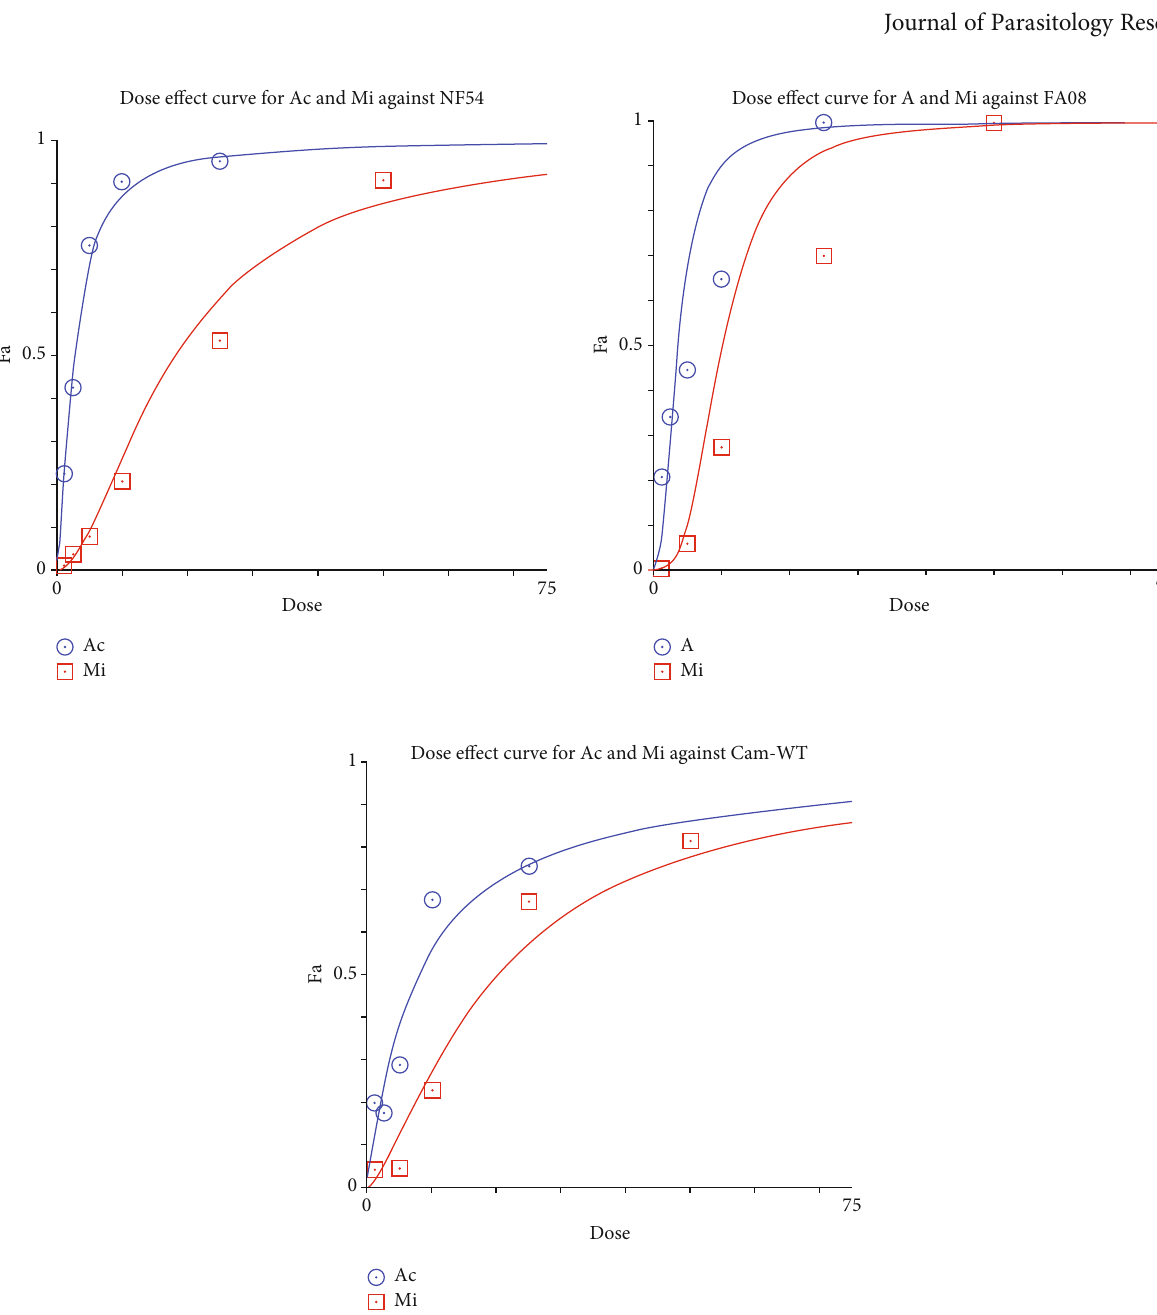
Figure 1: Dose-response curves for A . cordifolia (Ac) and M . indica (Mi) against P . falciparum parasites. The SYBR Green I in vitro drug assay was used to determine the dose-response curves for the NF54, FA08, and Cam-WT (CamWT_C580Y) parasite